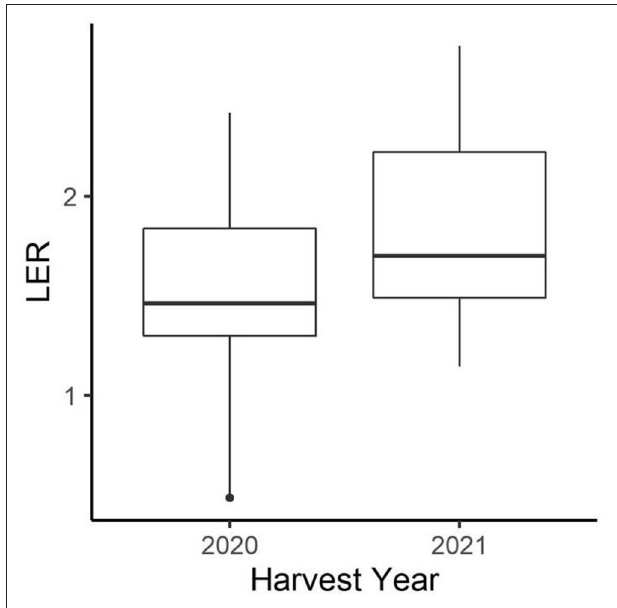
FIGURE 2 | Distribution of peaola LER across all treatments in 2020 and 2021. The year 2021, which had much lower yields, had a higher average LER across all peaola treatments.